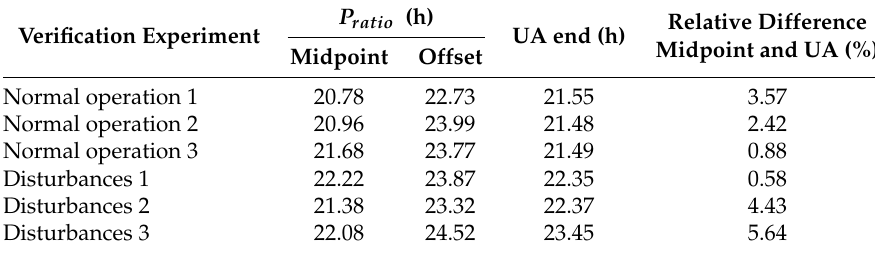
Table 3. Summary of the end of primary drying verification for the six experimental